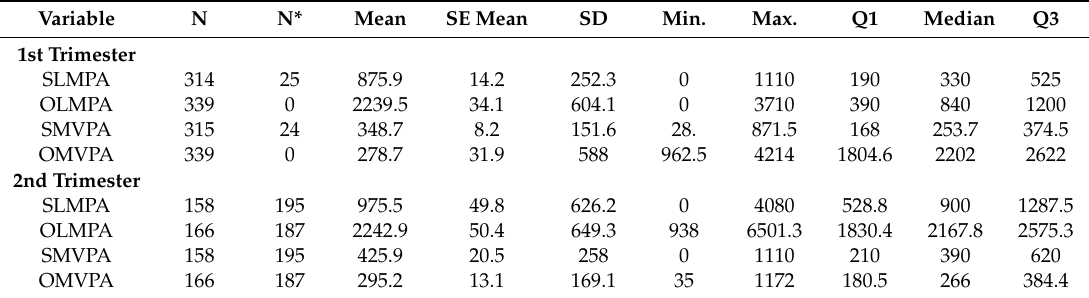
Table 1. 1st and 2nd trimesters’ physical activity (PA) levels (min / week) according to both subjective (self-reported) and objective (accelerometer-based) methods.